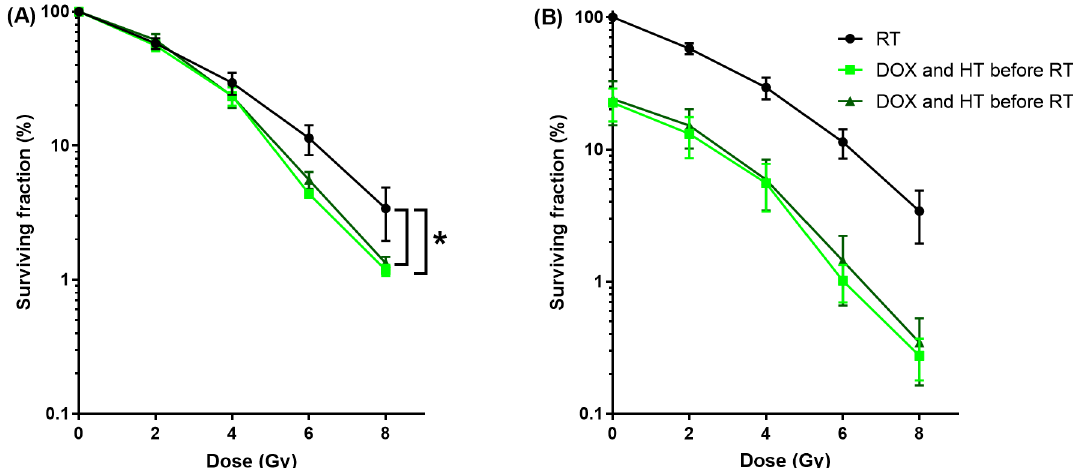
Fig 6. Cytotoxicity of HT and DOX before and after RT. Surviving fraction as function of radiation dose. Cells were exposed for 1 hour to DOX (0.02 μ g/mL) at 43˚C before or after RT. Both DOX and HT before and after RT resulted in a significant enhancement of the RT normalized for DOX and HT at 0 Gy (A) and normalized for untreated samples (0 μ g/ml, 37˚C and 0 Gy) (B).